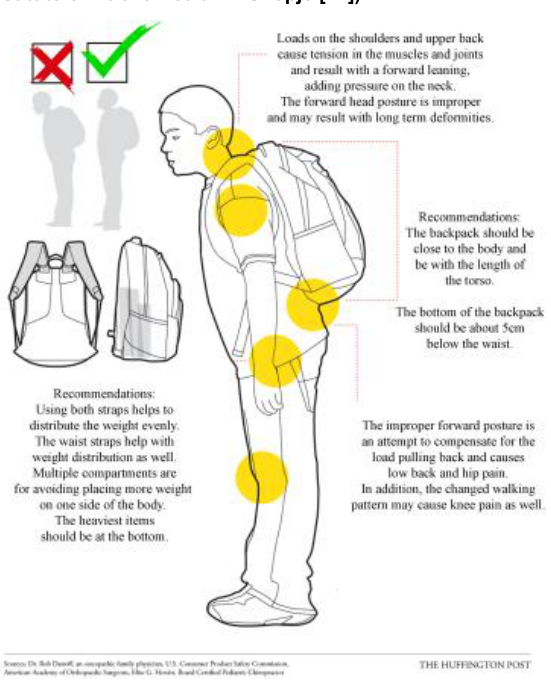
Figure 6. Influence of backpacks on the back and posture of children (Adapted from Jan Diehm, Source: